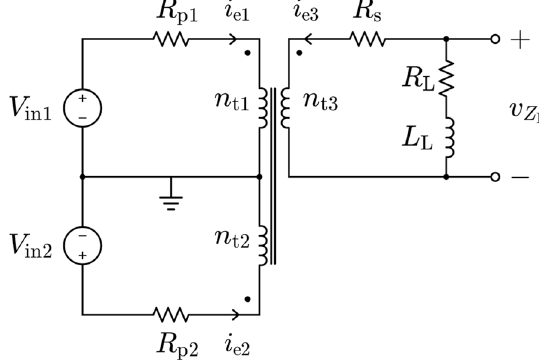
Fig. 10 A possible output stage of vacuum tube guitar